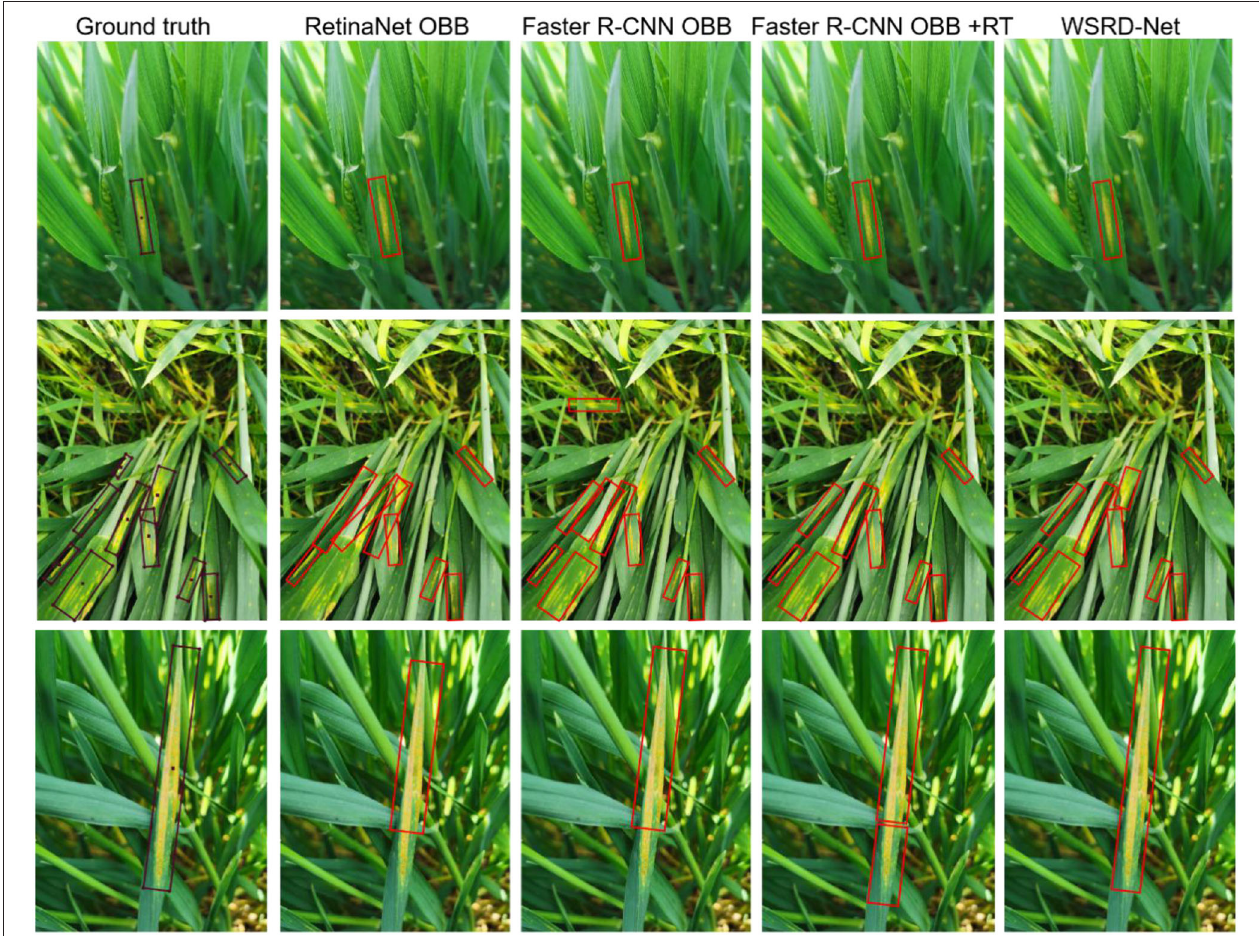
FIGURE 13 | Visualization of the comparison results with other oriented object detection models.